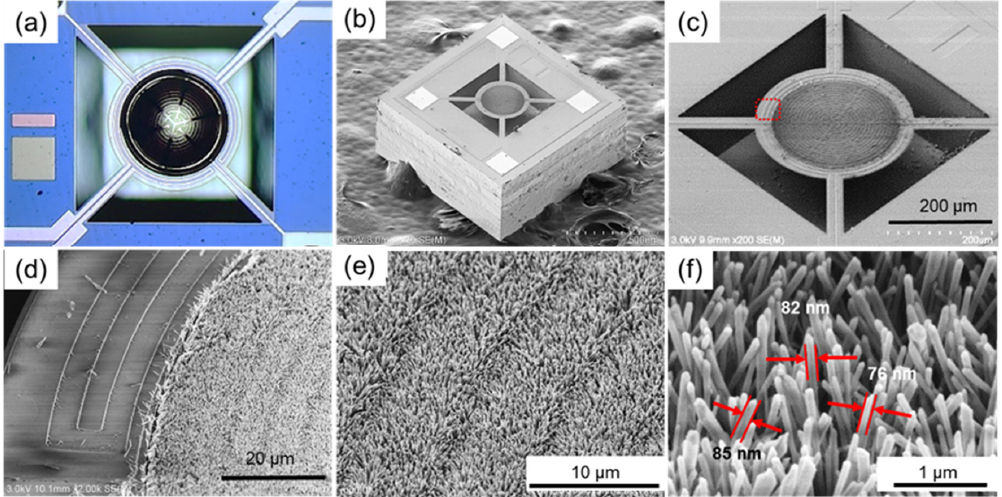
Figure 2. ( a ) An optical image showing the seed layer solution loading process. ( b , c ) SEM image of sensor chip after ZnO NWs growth process; the nanowires are immobilized in the sensing area, while NWs are barely found in other areas. The magnified SEM image of ( c ) is shown in ( d ). The boundary of the sensing area is quite clear. ( e ) The ZnO NWs are densely grown in the sensing area. ( f ) Zoom ‐ in view of the dense ZnO NWs; the nanowire diameter is around 80 ± 5 nm.